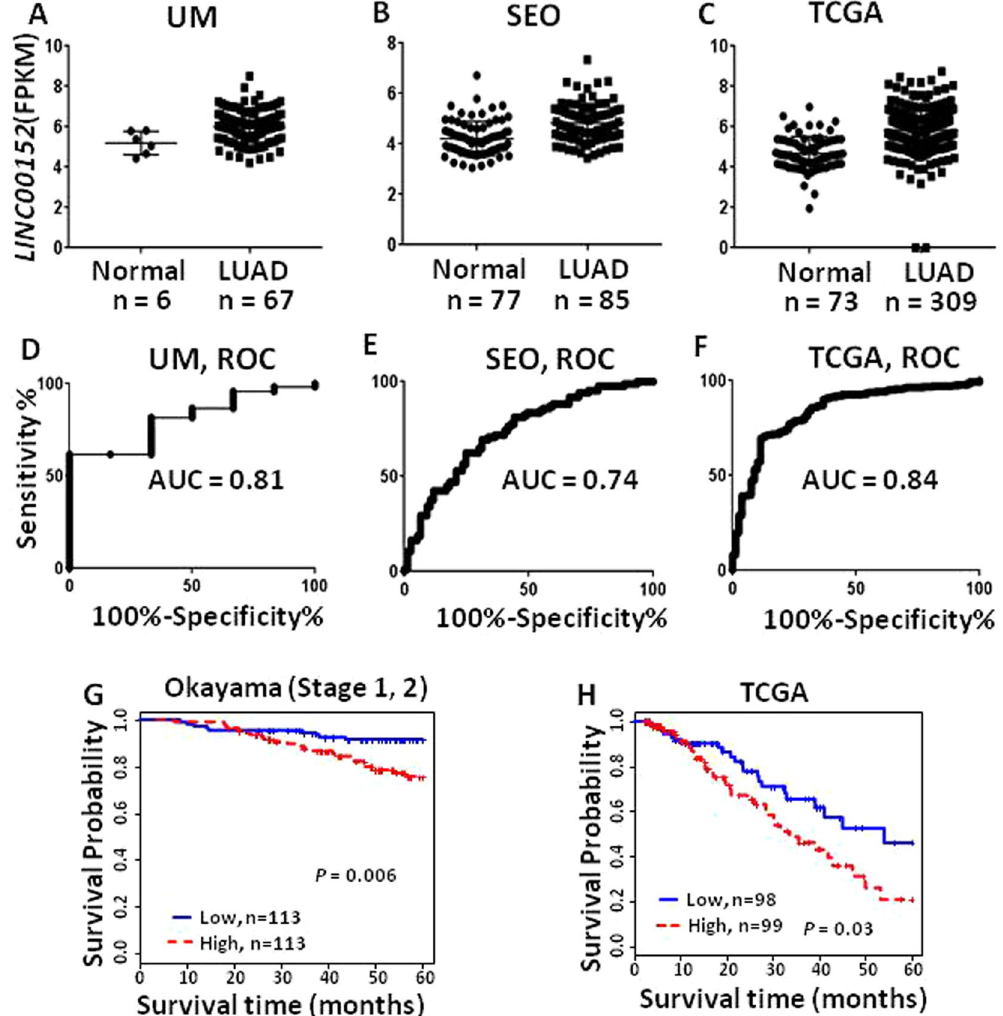
Figure 1. Differentially expression of LINC00152 in lung ADs. ( A–C ) Scatterplots of LINC00152 expression levels in lung AD and normal tissue samples in UM, Seo and TCGA RNA-Seq data sets (y-axis is log2 of FPKM value, LUAD vs. Normal, p < 0.001 in all 3 data sets). ( D–F ) ROC curves with AUC values of LINC00152 in UM (67 LUAD vs 6 N), Seo (85 LUAD vs 77 N) and TCGA (309 LUAD vs 73 N) RNA-Seq data sets. ( G and H ) Kaplan-Meier curves and log-rank test of LINC00152 in the Okayama (226 LUADs), and TCGA (197 LUADs) data sets. Higher LINC00152 expression was associated with poor patient